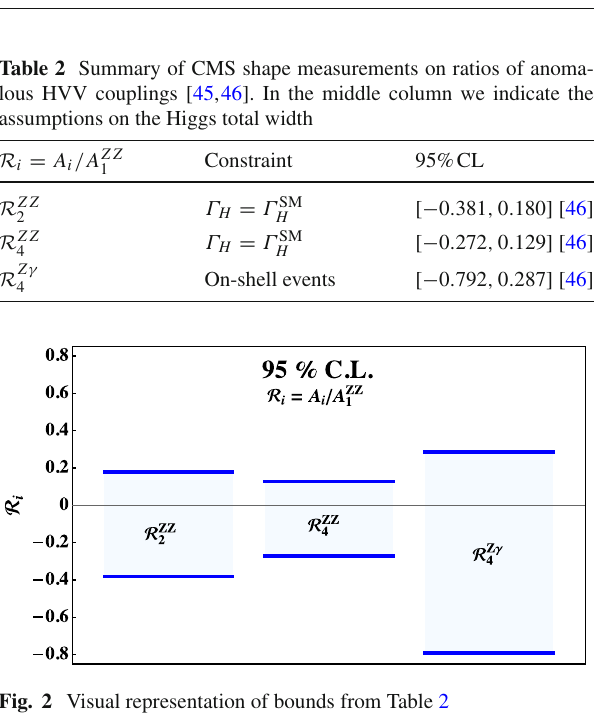
direct H → γ γ and H → Z γ two body decays. It turns out γ that only A Z is universal in nonlinear Higgs dynamics, as 2 γγ A requires shift-symmetry breaking effects. In Sect. 2